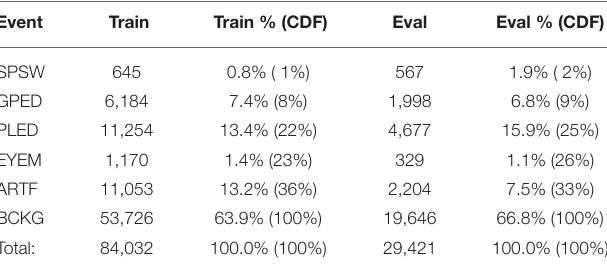
TABLE 1 | An overview of the distribution of events in the subset of the TUH EEG Corpus used in our experiments.